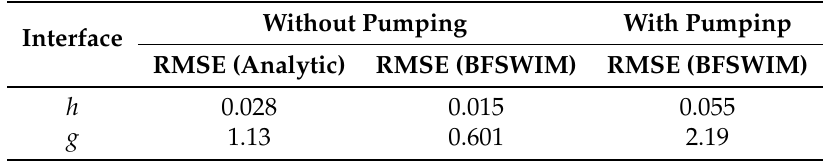
Table 3. The root mean square error of “FreeSWIM” model in each case in